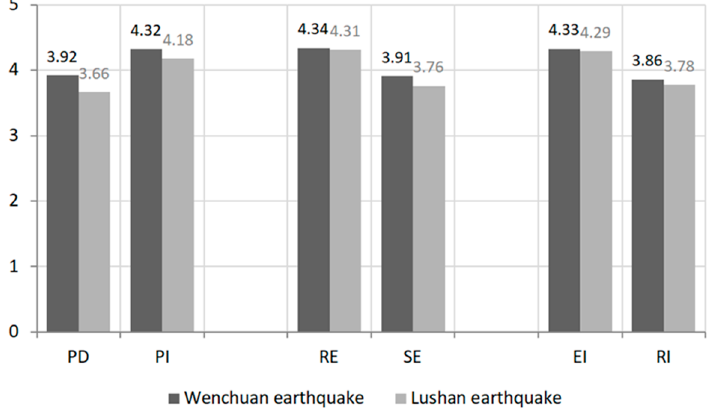
Figure 2. Place attachment, efficacy beliefs and risk coping characteristics of farmers in earthquake-threatened areas.